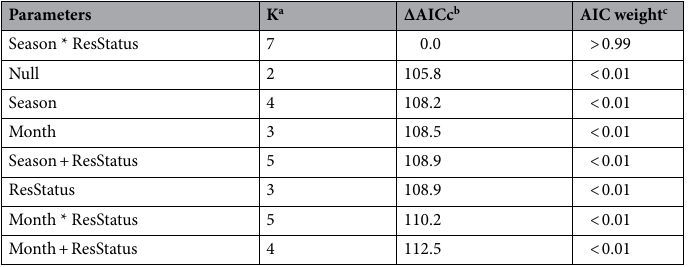
Table 4. Model selection results for analysis of seasonal/monthly variation in bird-window collisions. Results of model selection comparison among candidate negative binomial models that included factors potentially affecting raw counts of total fatal collisions (including feather piles) found in morning, midday, and evening collision surveys in Stillwater, Oklahoma, USA in 2015–2016. Parameters included Month (4 = April, 5 = May, etc.), Season (spring, summer, fall) and ResStatus (residency status of individual birds: resident and migrant birds were included in analysis; individuals of unknown residency status and of = unidentified species were excluded from analysis). a Number of model parameters. b Difference in AICc value between model and top model. c AICc Weight—relative support for model.